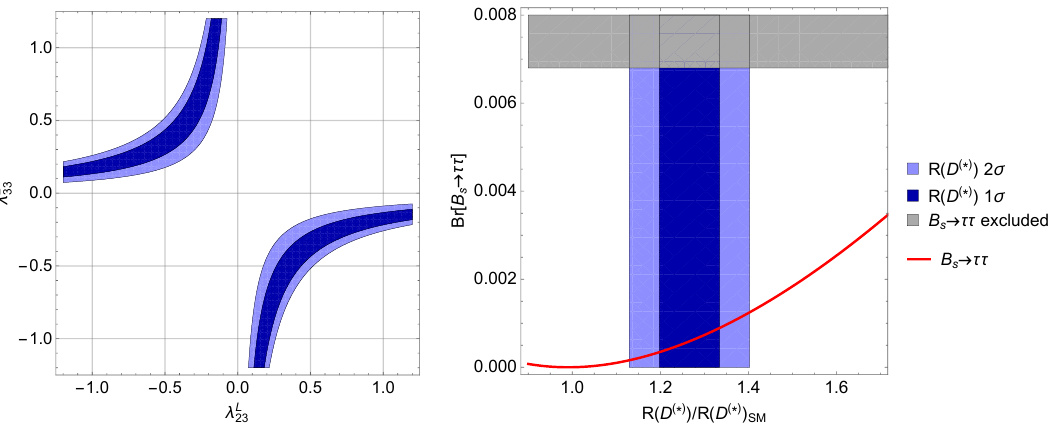
(cid:21) L plane for M = 1 TeV using 23 (cid:0) 33 (cid:28)(cid:28) (red) as a function of R ( D ( (cid:3) ) ) =R ( D ( (cid:3) ) ) SM . !